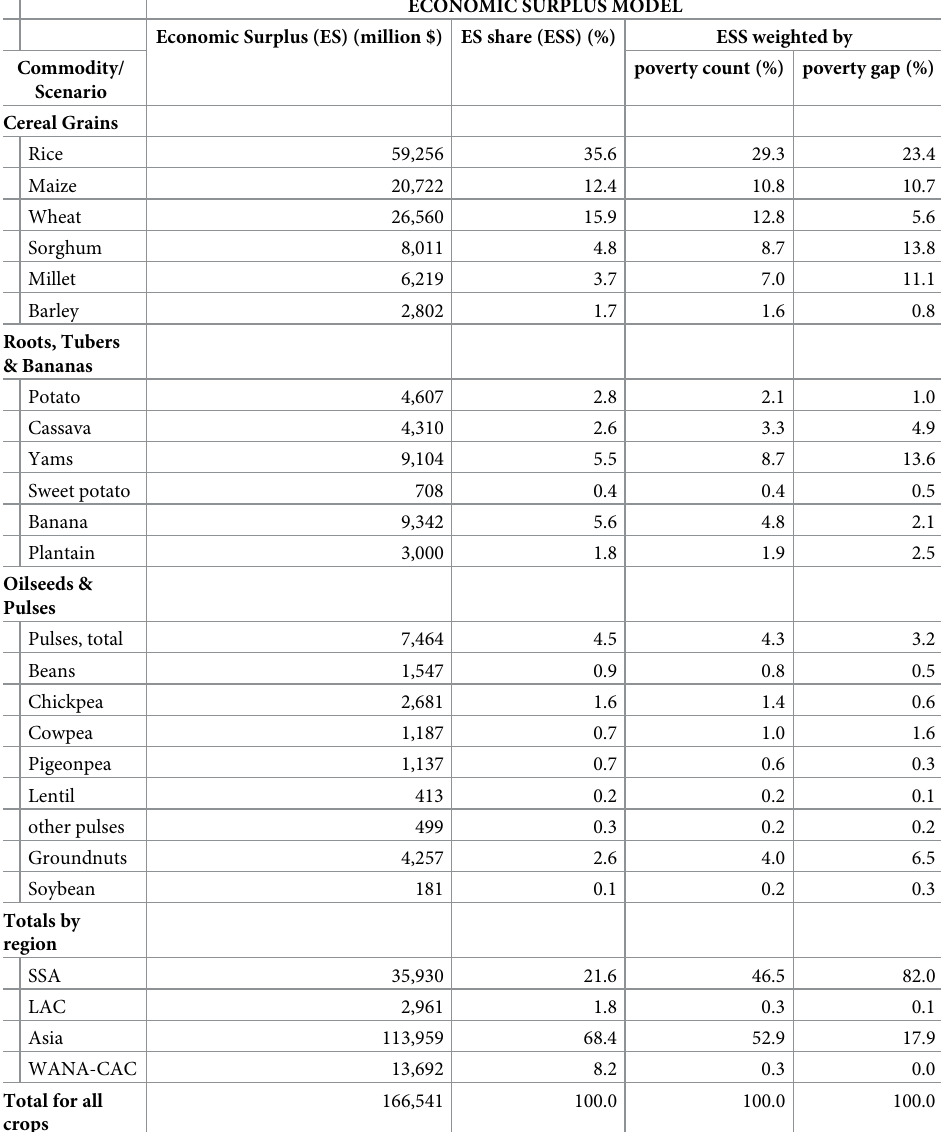
Table 6. Economic surplus model results: Change in economy-wide income in 2030 from faster productivity growth, as modeled by the IMPACT